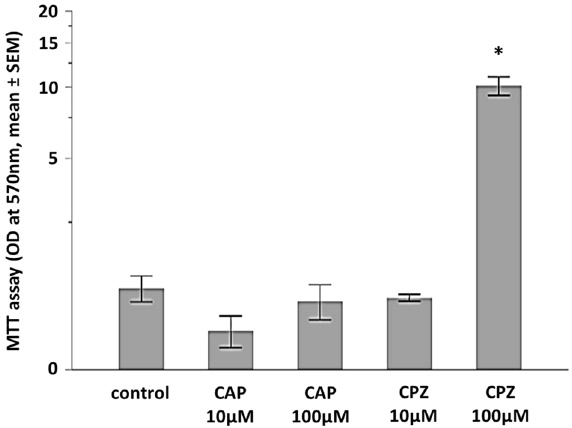
Figure 2. The metabolic activity of hiPSC-CMs is not affected by capsaicine (CAP), but by capsazepine (CPZ). Presented is the normalized optical density (OD) at 570 nm after application of a MTT assay measuring metabolic activity via NAD(P)H-dependent cellular oxidoreductase enzymes (mean ± standard error of the mean (SEM)). Kruskal–Wallis p < 0.0001, * p < 0.001 CPZ 100 µM versus control. For better presentation of low values, the y-axis was scaled logarithmic. Unstimulated cells, n = 16, n = 3 independent experiments, n = 3–7 biological replicates per experiment. CAP 10 µM, n = 9, n = 2 independent experiments, n = 3 and 6 biological replicates per experiment. CAP 100 µM, n = 14, n = 3 independent experiments, n = 3–6 biological replicates per experiment. CPZ 10 µM, n = 4, n = 1 independent experiment, n = 4 biological replicates. CPZ 100 µM, n = 17, n = 3 independent experiments, n = 3–9 biological replicates per